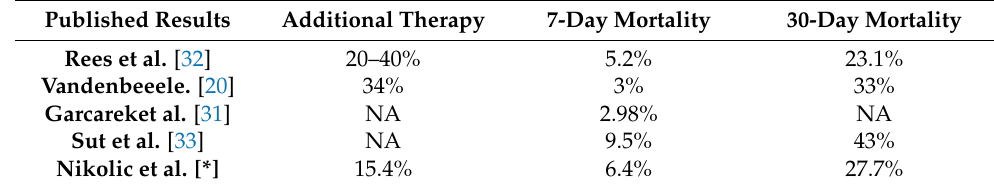
Table 5. Clinical outcomes after